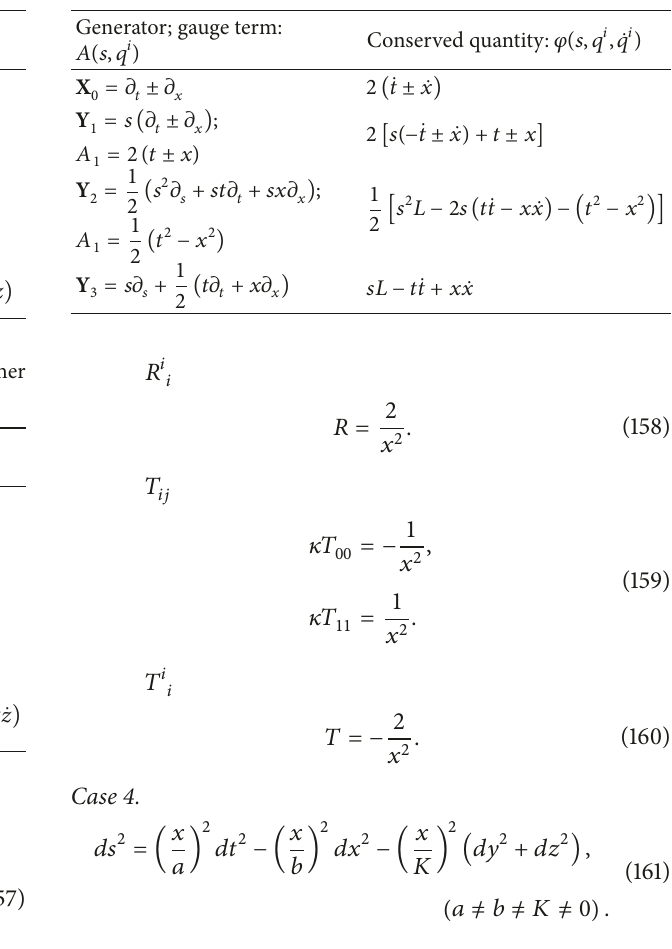
Table 28: Conserved quantities corresponding to each Noether